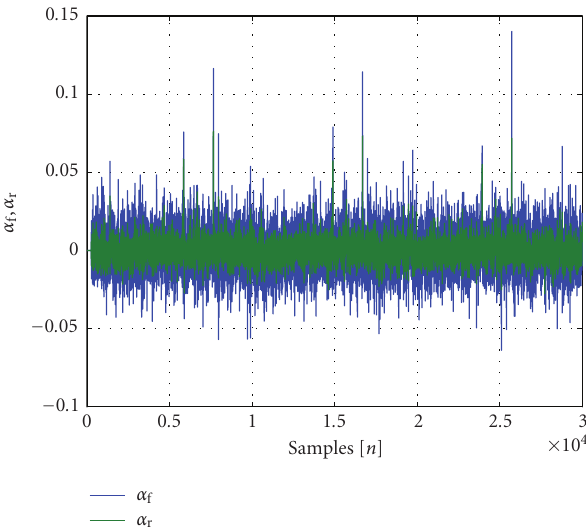
Figure 4: The two residuals α f [ n ] and α r [ n ] computed for a disc with a scratch and a skewness problem.